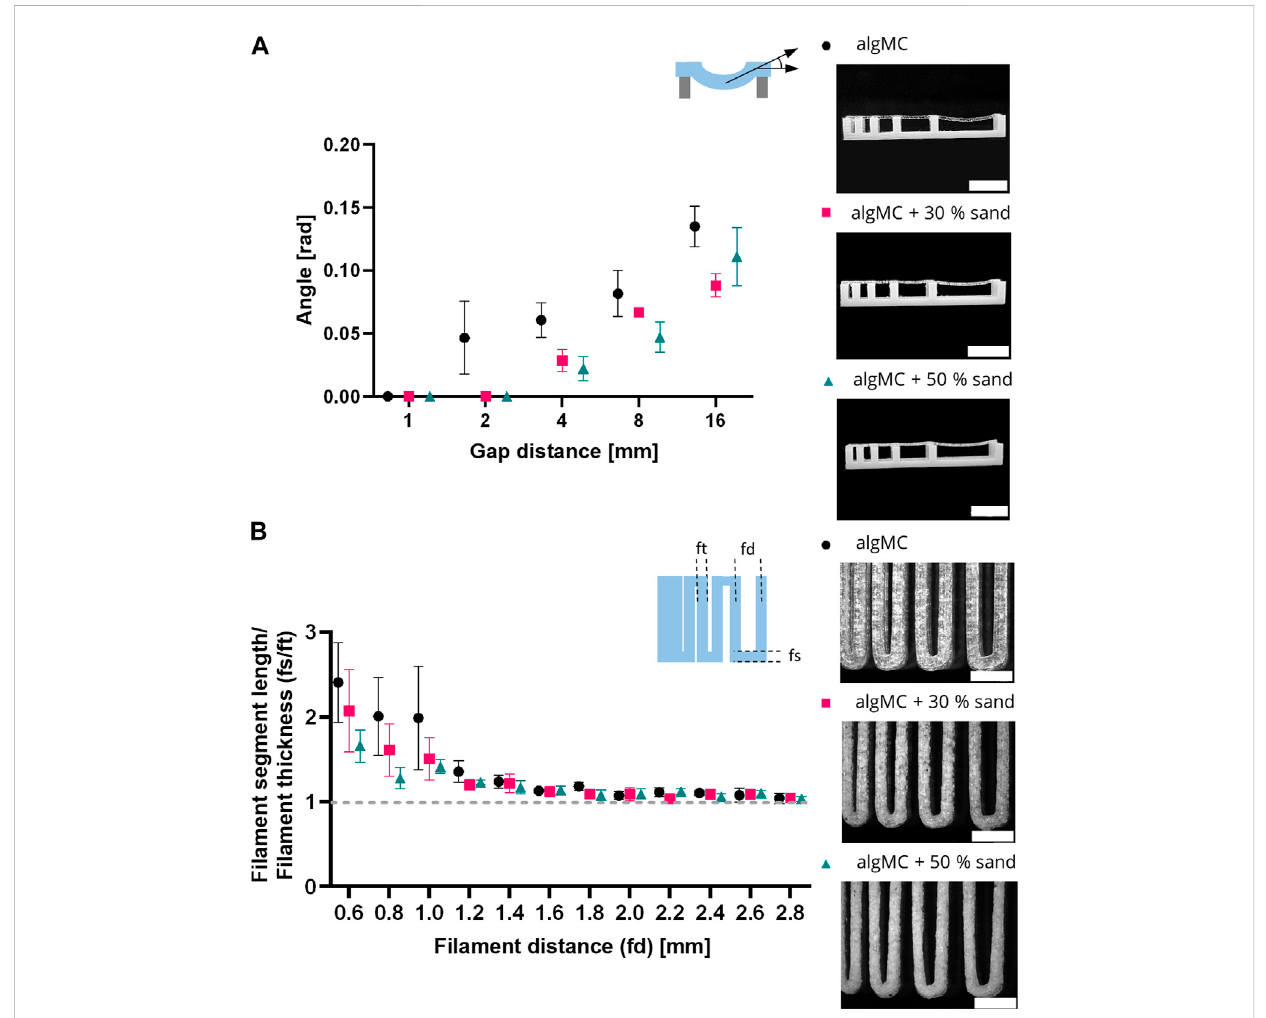
FIGURE 3 Printability characterization of the 3 wt% alginate and 9 wt% methylcellulose (algMC) ink with the addition of 30 wt% and 50 wt% sand, respectively. (A) Filament collapse test (mean ± SD, n = 3). Scale bar = 10 mm. (B) Filament fusion test (mean ± SD, n = 5). Scale bar = 4 mm.